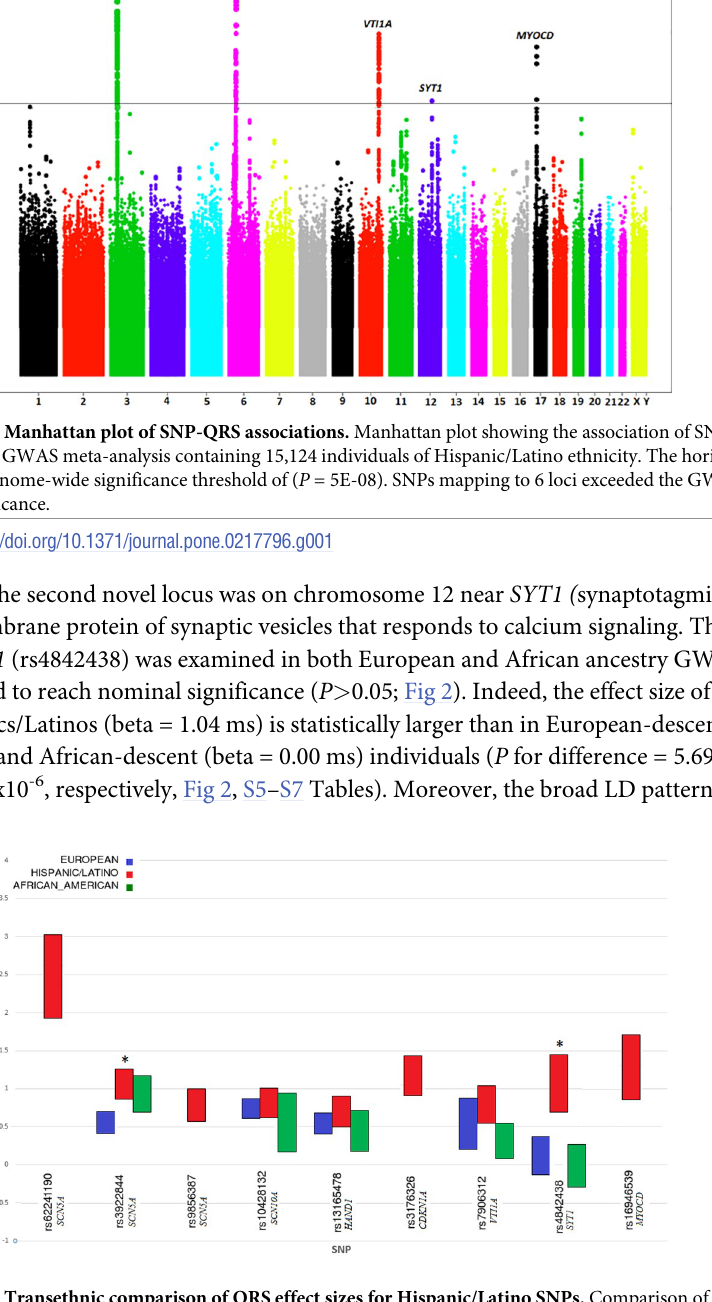
Fig 2. Transethnic comparison of QRS effect sizes for Hispanic/Latino SNPs. Comparison of effect sizes and 95% confidence intervals for the 9 index SNPs that were genome-wide significant in the Hispanic/Latino QRS duration GWAS, and the effect sizes for corresponding SNPs in the European and African American GWAS. SNP rs10428132 was not directly measured in the European or African American studies, but instead a SNP in perfect LD (r 2 = 1) was used (rs6800541). Other SNPs that were not directly measured in Europeans or African Americans are not presented (rs62241190, rs9856387, rs3176326, and rs16946539). � Refers to SNPs where the difference in effect size between two ethnic groups was significant at the Bonferroni corrected P -value. Two SNPs showed larger effects in Hispanics/ Latinos than in European-descent individuals: rs3922844 in SCN5A and rs4842438 in SYT1 . See S7 Table for additional